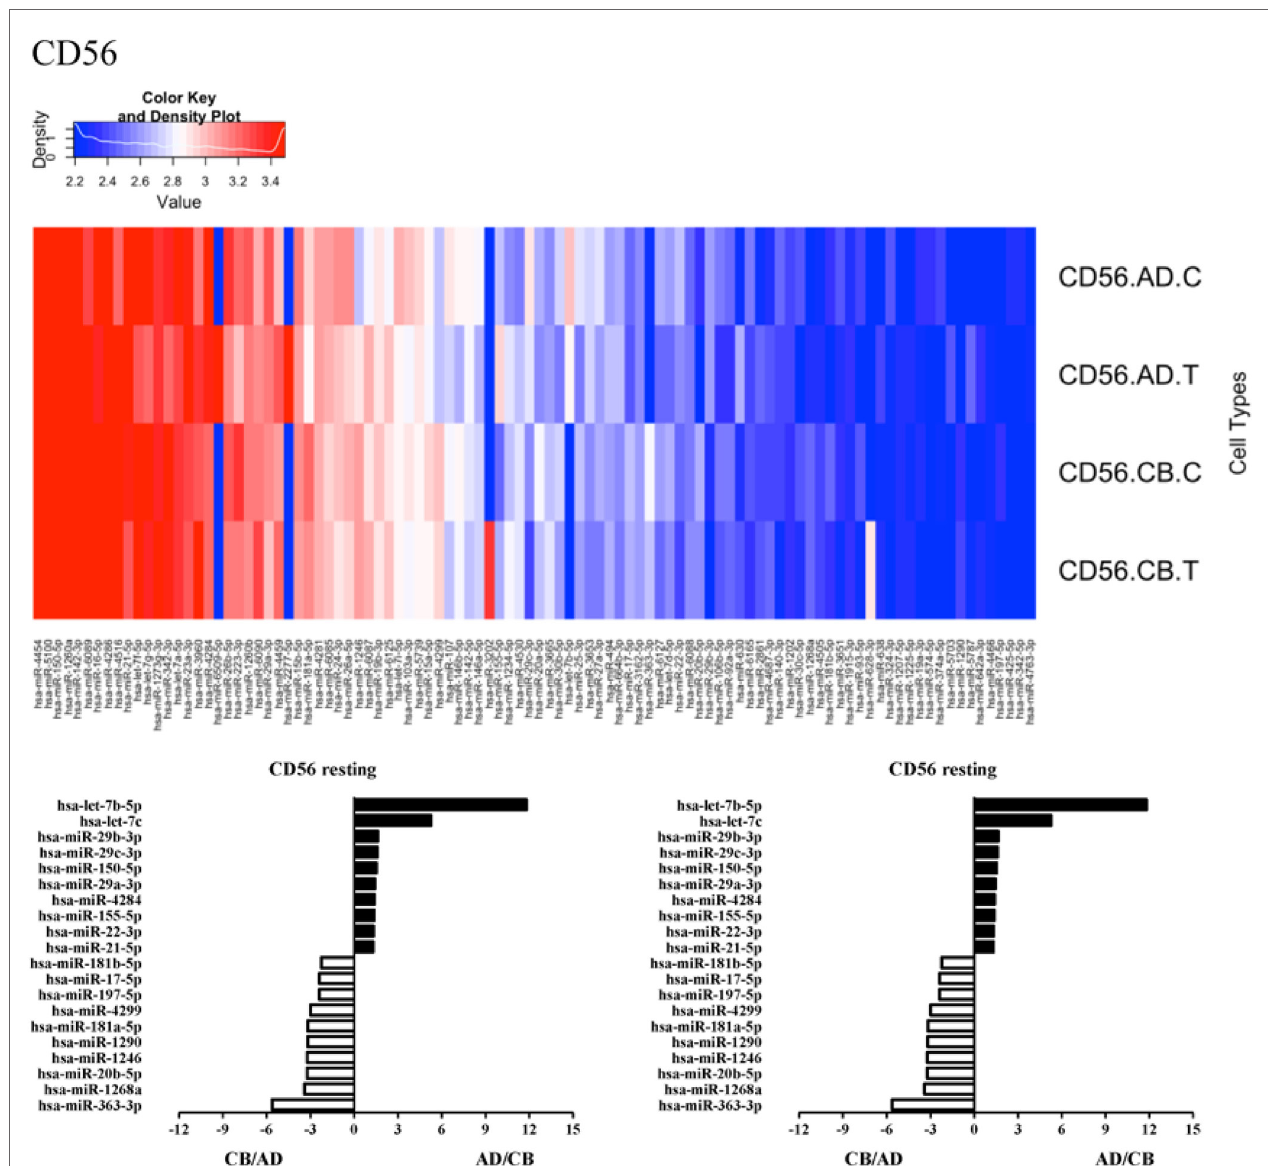
FigUre 8 | Differential microrna profiles between adult and neonatal cD56 + natural killer cells